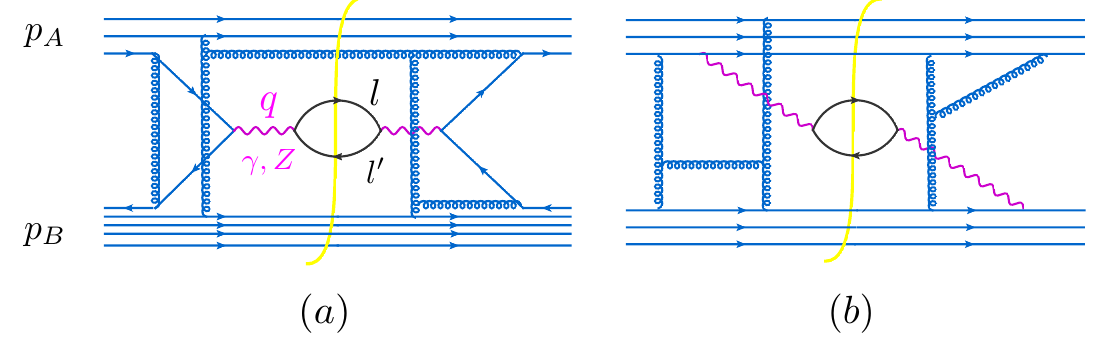
Figure 1 . Typical annihilation-type (a) and exchange-type (b) diagrams for DY particle produc-